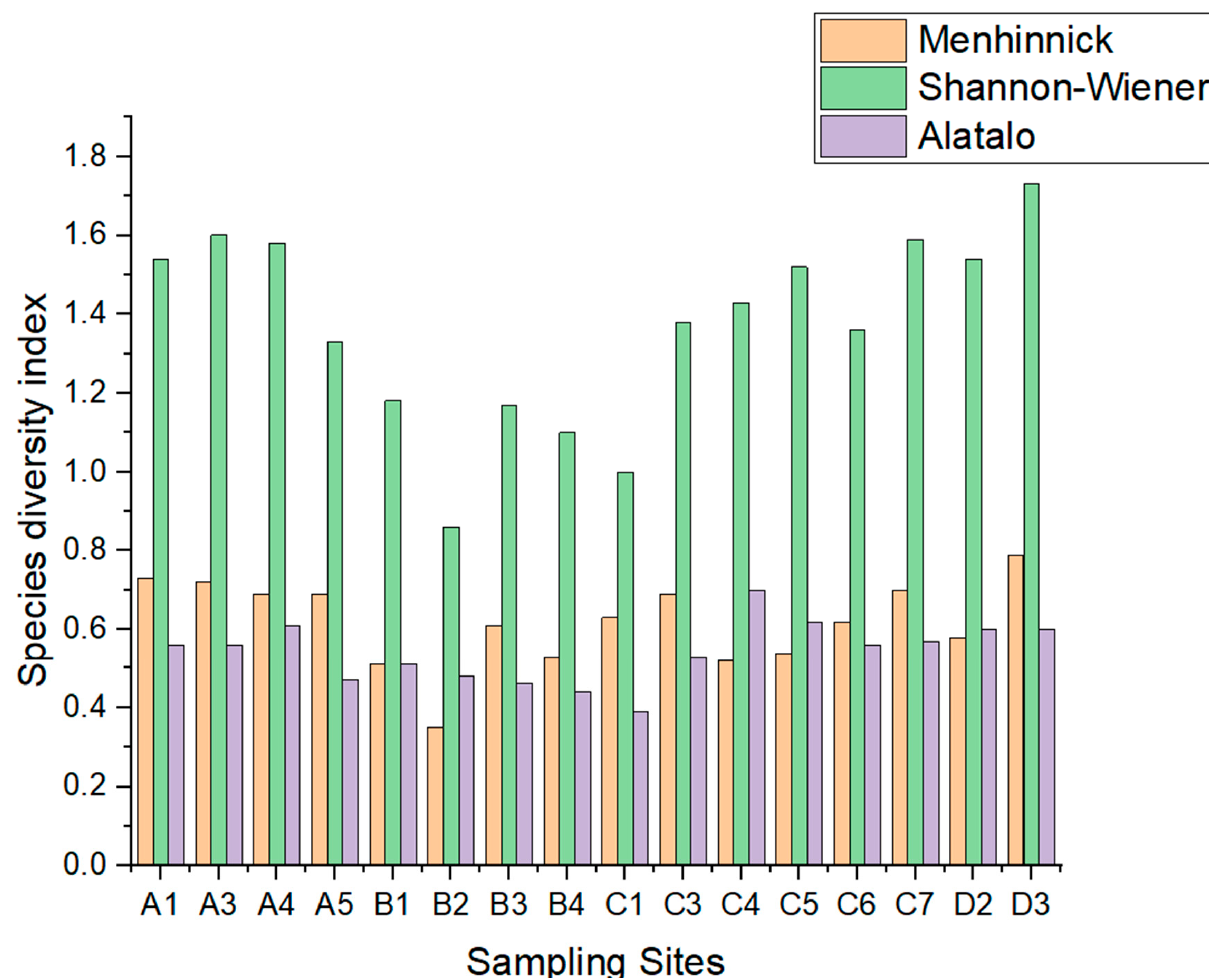
Figure 2. Species diversity map of 16 tree sample plots. The orange, green, and blue bars represent the Menhinnick richness index ( D ), Shannon–Wiener diversity index ( H ), and Alatalo evenness index ( E ), respectively.